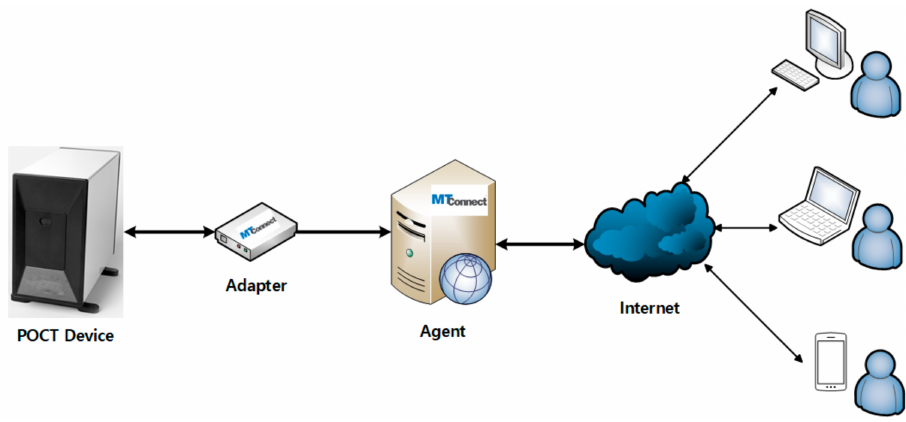
Figure 1. Working principle of MTConnect with point-of-care testing (POCT) device.